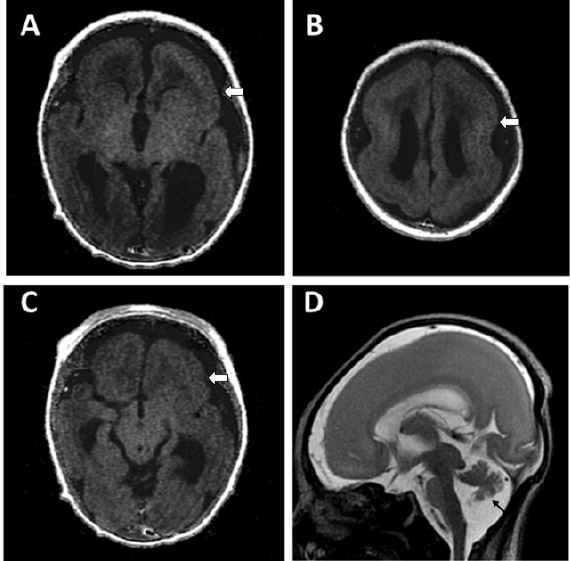
Figure 5. Brain MRI of Case 2 showed lissencephaly (white arrows), mildly dilated posterior horns of ventricles with dysgenesis of carpus callosum, and small vermis (arrow) (( A – C ): T1WI, ( D ): T2WI).